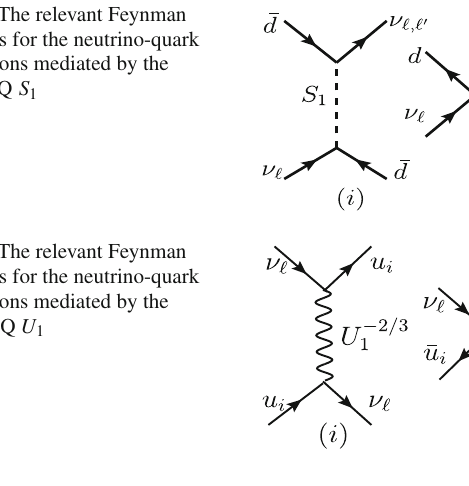
Fig. 3 The relevant Feynman diagrams for the neutrino-quark interactions mediated by the scalar LQ S 1